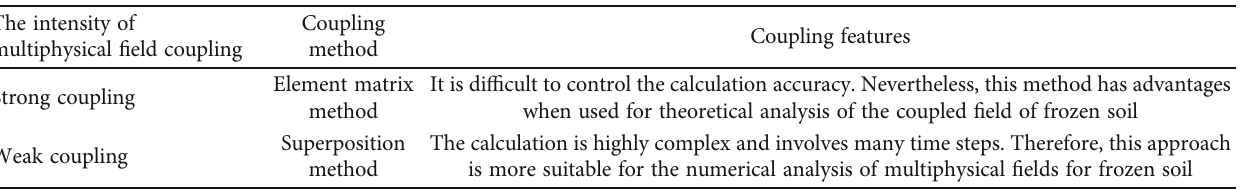
Table 1: Intensity of multiphysical fi eld coupling of the frozen soil and the features of coupling of di ff erent intensities. The intensity of